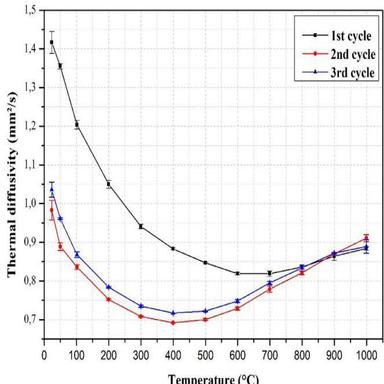
0. Thermal diffusivity measurement of Cipolin rock during three consecutive thermal cycles.